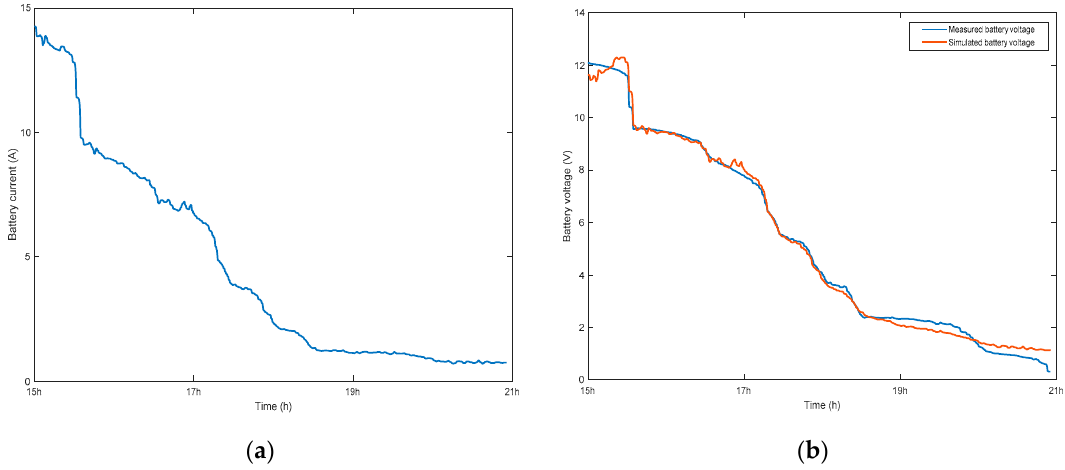
Figure 6. ( a ) The battery’s current in the discharging mode; ( b ) The simulation and experimental battery’s voltage in the discharging mode.